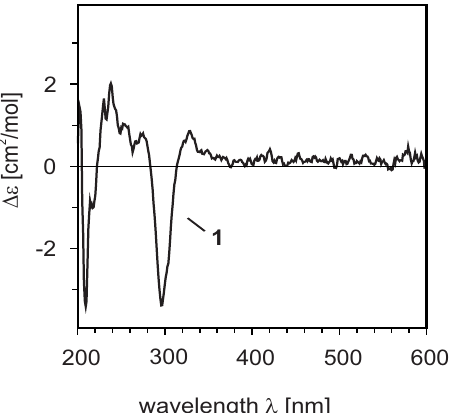
Figure 3. Experimental CD spectrum of compound 1